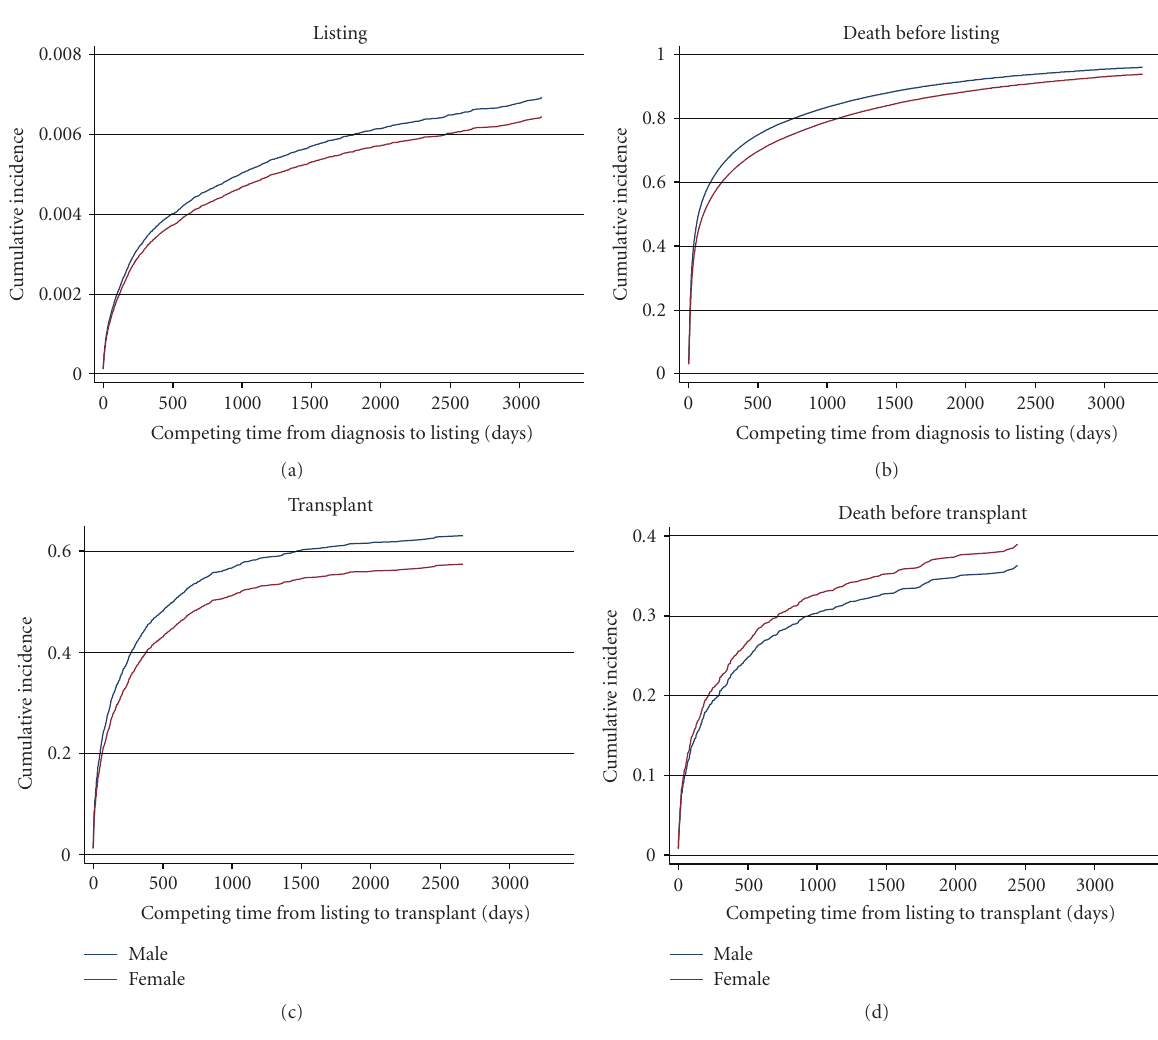
Figure 1: Gender-related results in the adjusted competing risks